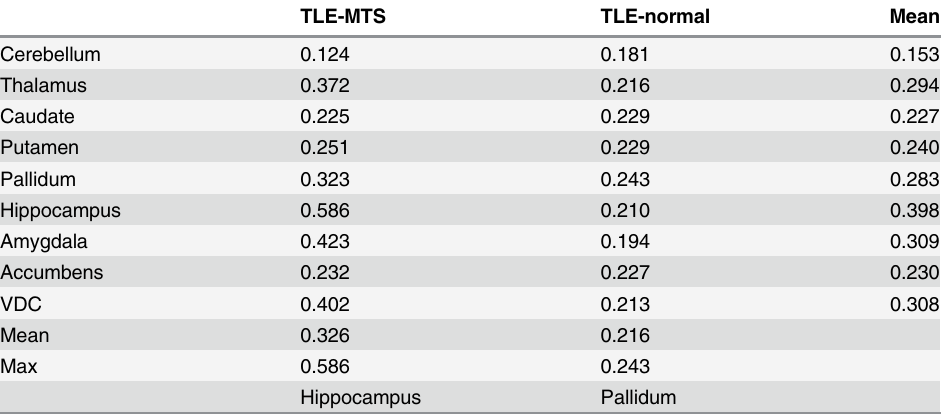
Table 2. Subcortical Pearson correlation R of the estimated atrophy and the t -statistics for both epi- lepsy types. “ Max ” refers to the overall highest R and the corresponding region, all located in the ipsilateral hemisphere. TLE-MTS TLE-normal